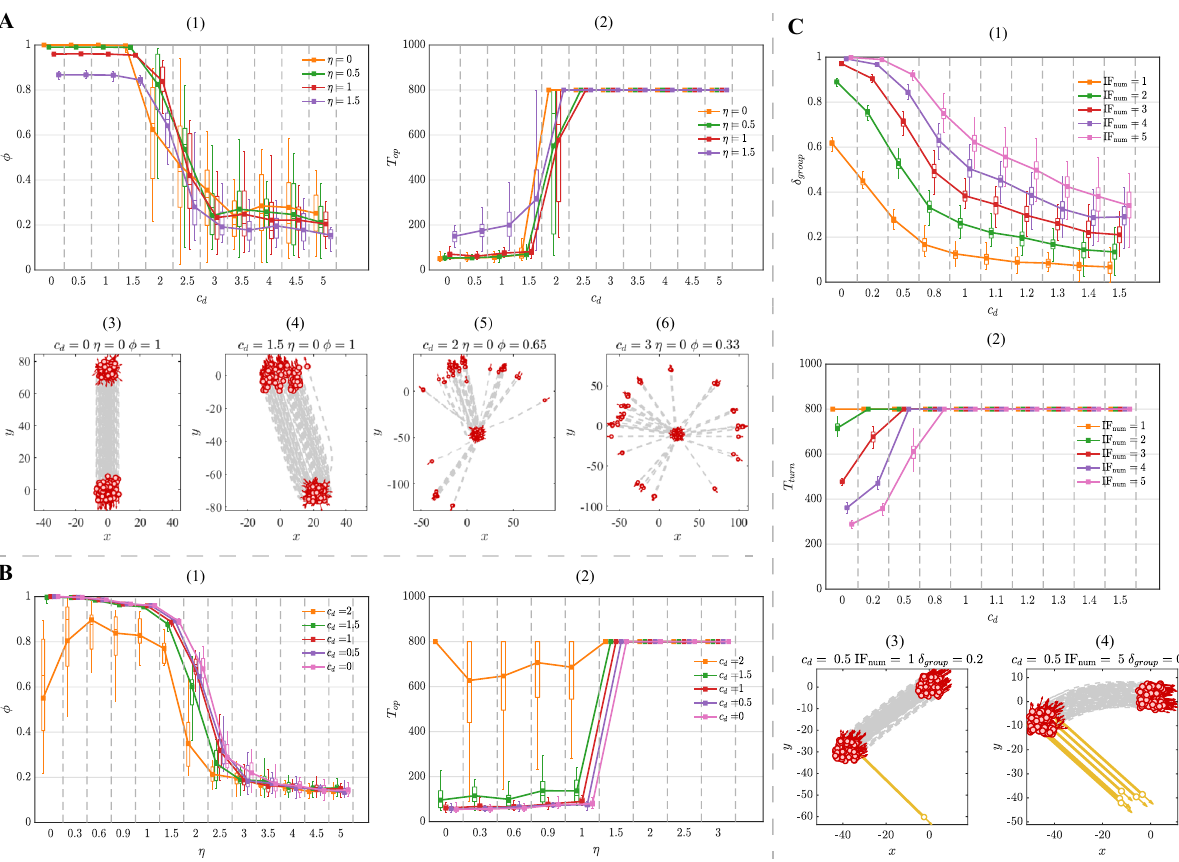
Figure 2. ( A ) The property of flocking with the evolution of c d in the DIST-S model. ( A -(1)) The polarization φ as a function of c d . ( A )-(2)) The convergence time T op as a function of c d . ( A -(3–6)) The trajectories of flocking with different c d . ( B ) The property of flocking with the evolution of noise η in the DIST-S model. ( B - (1)) The polarization φ as a function of noise η . ( B -(2)) The convergence time T op as a function of noise η . ( C ) The property of responsivity to stimulus with the evolution of c d in the DIST-S model. ( C -(1)) The response accuracy δ group as a function of c d . ( C -(2)) The response time T turn as a function of c d . ( C -(3–4)) The trajectories of response to stimulus with different c d . T op = 800 or T turn = 800 indicate that the group is unable to finish the corresponding case within the total simulation time. Each data point represents the average of 50 simulation runs with the boxplot. Boxplots in the block divided by the dotted line belong to the same data point but are shifted at different positions on the x-axis to be more